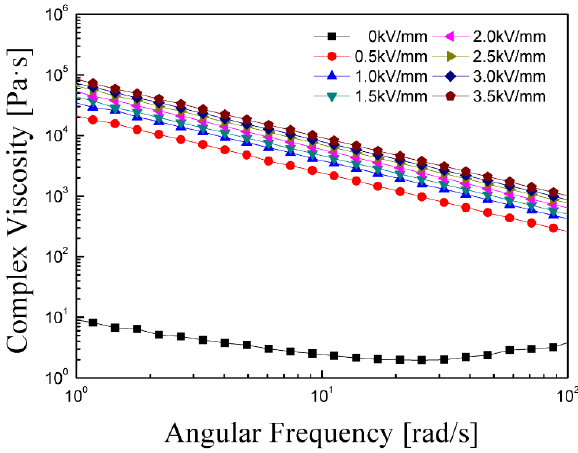
Figure 7. Complex viscosity ( η *) of PMMA-PNMA particle-based ER fluid as a function of angular